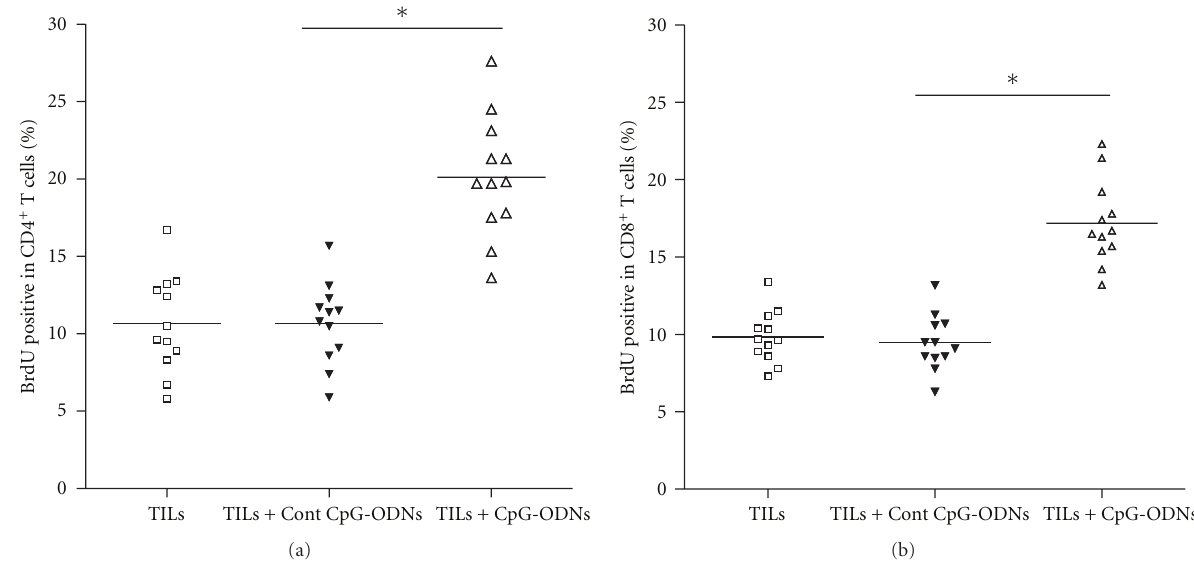
Figure 3: CpG-ODNs enhanced the local proliferation of CD4 + T cells and CD8 + T cells. TILs were collected from lung cancer patients ( n = 12) and treated with CpG-ODNs or control CpG-ODNs as described in Materials and Methods. 1 × 10 7 autologous TILs were transferred into the tumor bearing Balb/c nude mice with 100ug CpG-ODNs or control CpG-ODNs through tail vein. Four days later, the recipients were treated with 2mg BrdU i.p. every other day and up to a cumulative dose of 8 mg BrdU. Eight hours after the last BrdU injection, the lymphocytes were isolated from tumor mass and the proliferation of CD4 + T cells (a) and CD8 + T cells (b) was examined by FACS. ∗ P < .